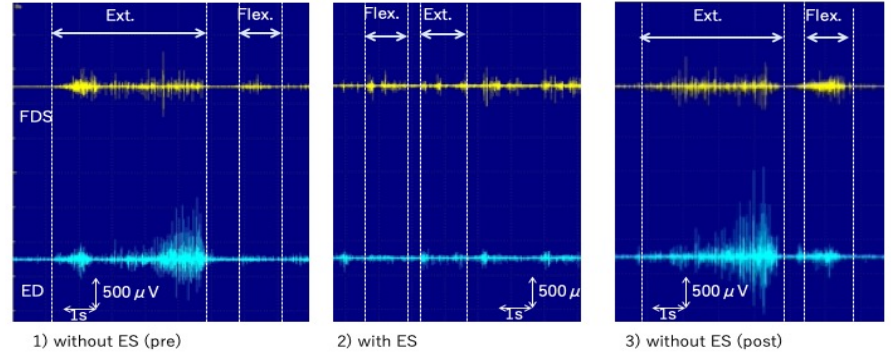
Figure 1. sEMG with or without the electrical stimulation. ES: the electrical stimulation, Ext.: extension, Flex.: Flexion, ED: extensor digitorum muscle, FDS: flexor digitorum superficialis muscle, sEMG: surface electromyogram.